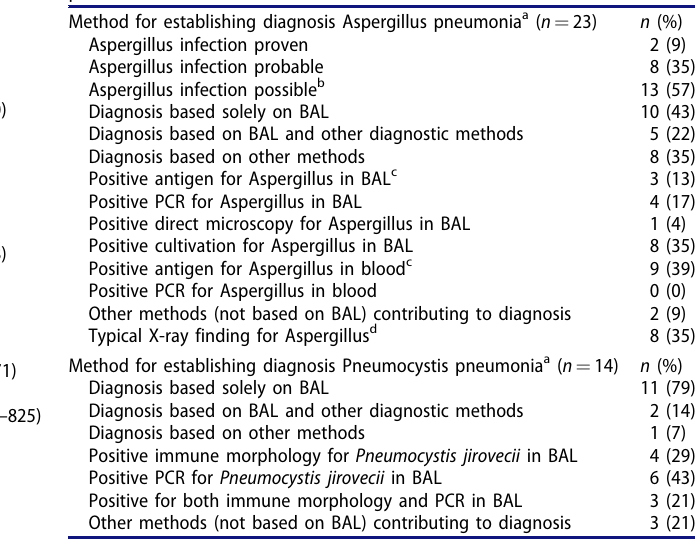
Table 3. Methods for establishing Aspergillus pneumonia and Pneumocystis